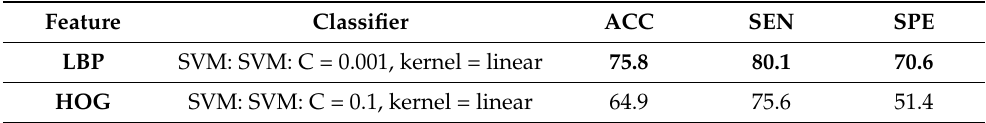
Table 4. PD classification results and optimal parameters analyzing surprise expression.